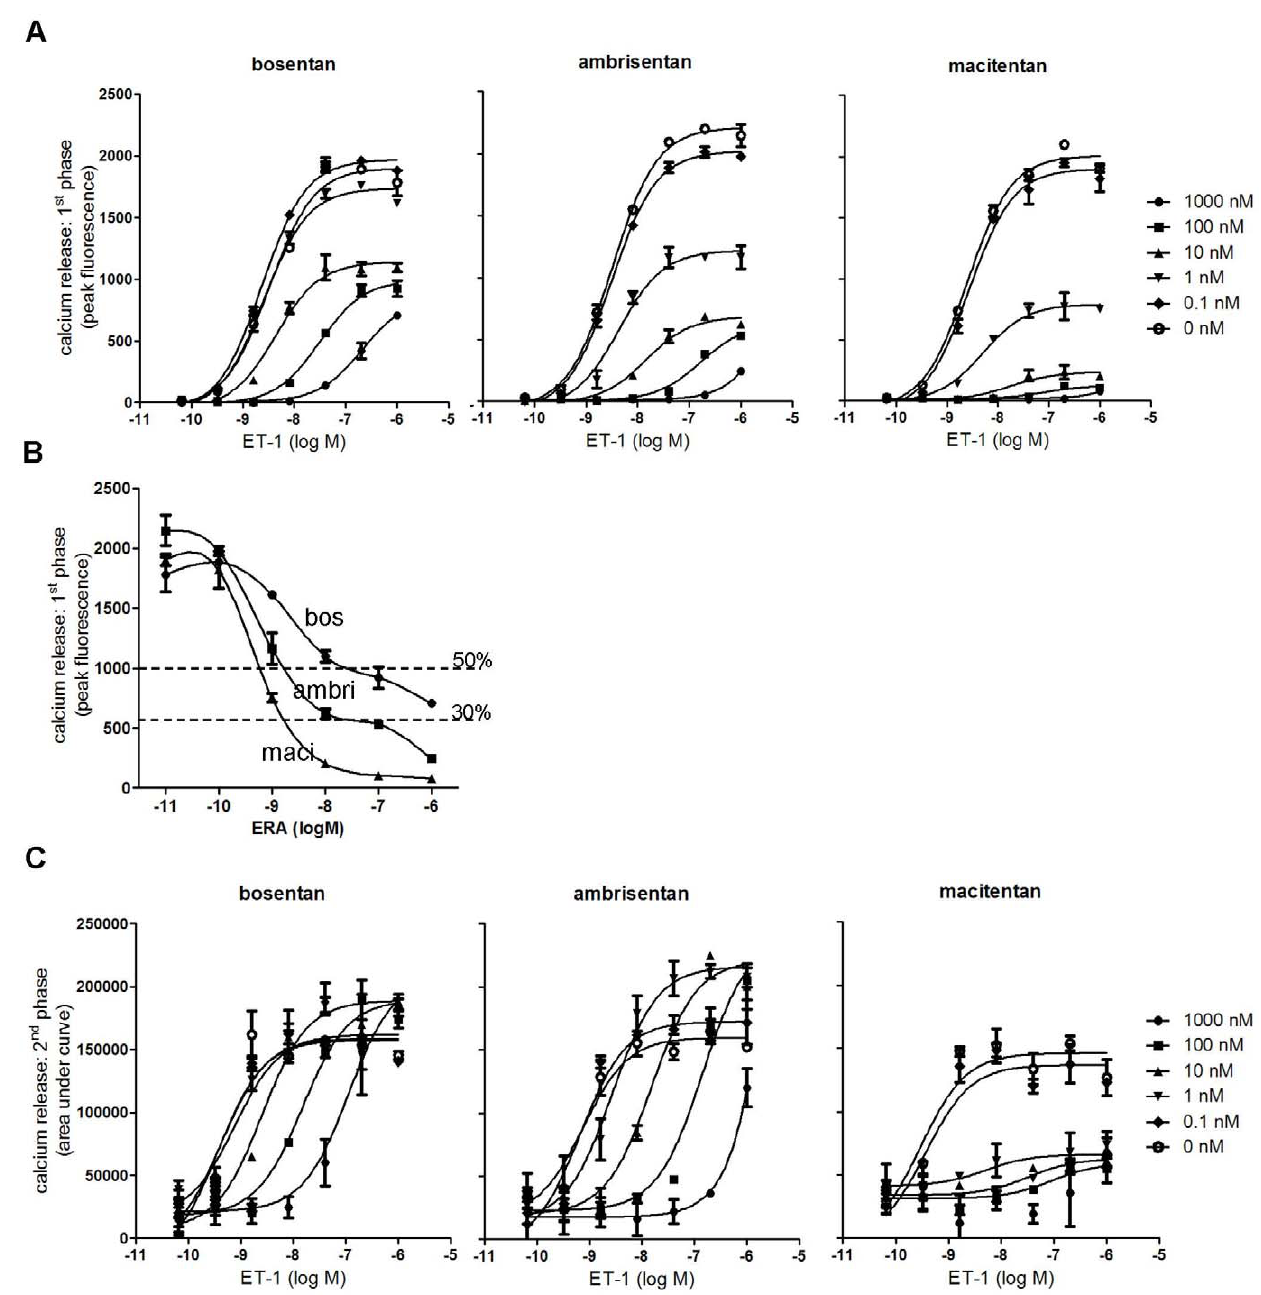
Figure 7. Effect of bosentan, ambrisentan and macitentan on both phases of the ET-1-induced calcium response. Human PASMCs were pre-incubated with dilution series of antagonists for 120 min, stimulated with a dilution series of ET-1 and the biphasic calcium response was recorded. Shown is the effect of antagonists on the ET-1 concentration-response-curves of the first response phase (A, using peak fluorescence values + / 2 SD of duplicates) and the second sustained response phase (C, using area under the curve values + / 2 SD of duplicates). Furthermore, the concentration-response-curves of the three antagonists for antagonizing peak responses induced by 1 m M ET-1 are shown + / 2 SD of duplicates (B) with the approximate localization of intermediate plateaus of antagonist efficacy. Shown are the results of one representative experiment out of n=3 experiments. Fig. 7C shows the antagonistic effects of the three compounds on these observations it can be estimated that within the first 30 on the second sustained phase of calcium elevation. Macitentan seconds, bosentan had dissociated from , 50% of the receptors displayed an insurmountable mode of antagonism while the other and ambrisentan from , 30% of receptors (assuming a 1:1 two compounds showed surmountable antagonism. Using the correlation between signal and receptor occupancy and lack of Cheng-Prusoff equation, the K b values were calculated for the first receptor reserve). These considerations yield a very short ROt 1/2 (K b1, using IC 50 values at 8 nM ET-1) and second phase (K b2 of , 1 minute for ambrisentan and bosentan.